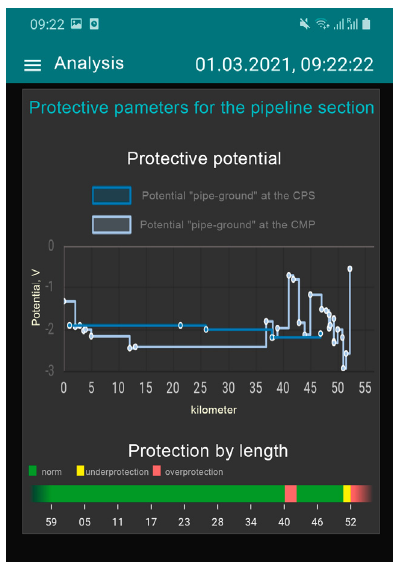
Figure 6. Dashboard with monitoring data on a mobile interface.